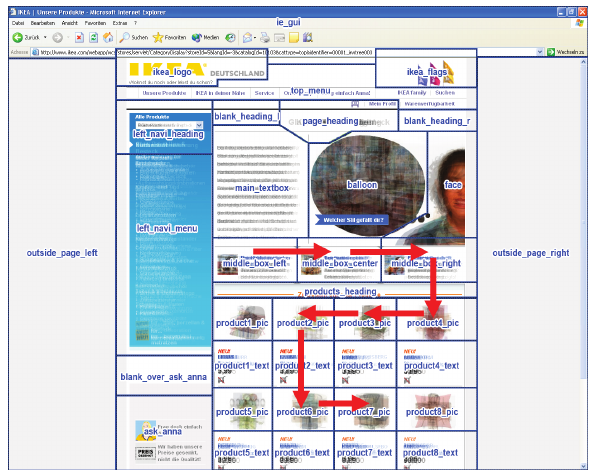
Figure 11. Often-repeated IKEA pattern involving 5 ROIs, occurring in 8 out of 10 presentations, initially in presentation 1 (participant